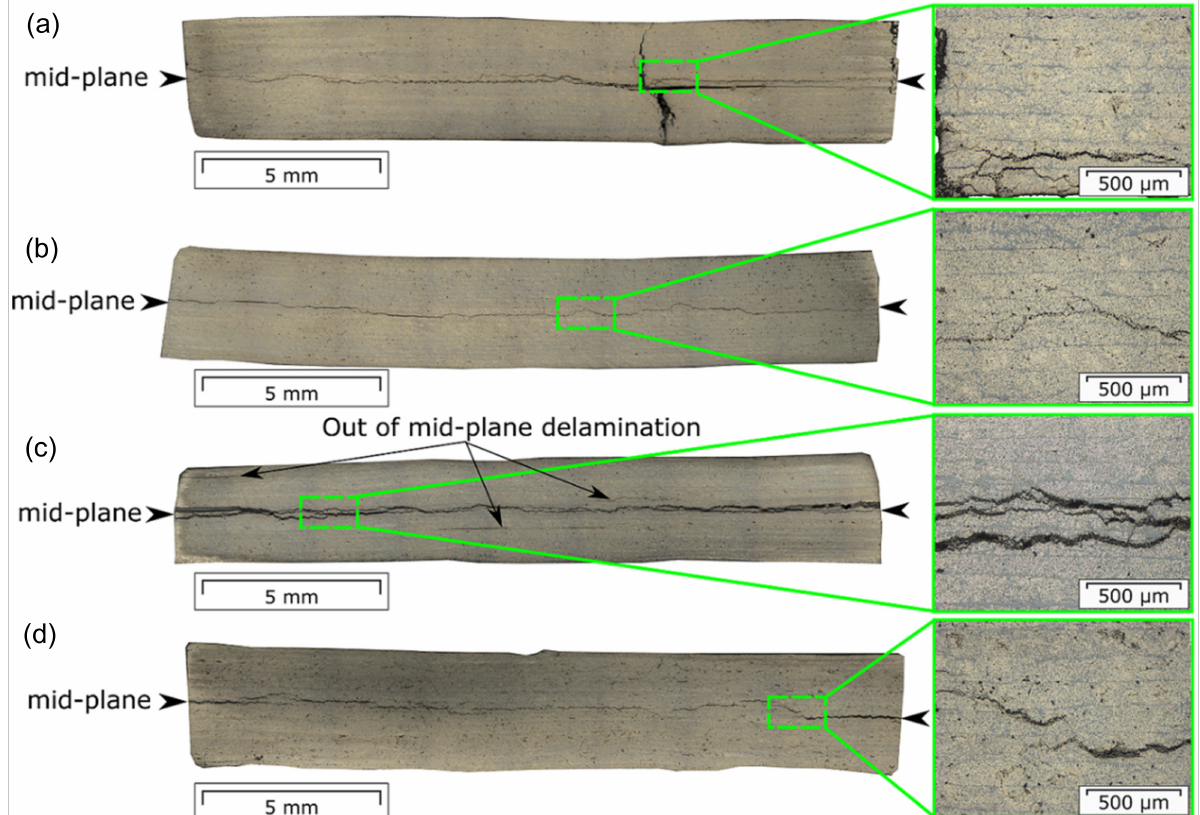
Figure 7. Micrographs of the polished cross sections of selected specimens after fatigue testing: ( a ) c-5-330-01; ( b ) c-10-350-03; ( c ) f-5-330-01; ( d ) f-10-350-02. The black arrows point at the mid-plane